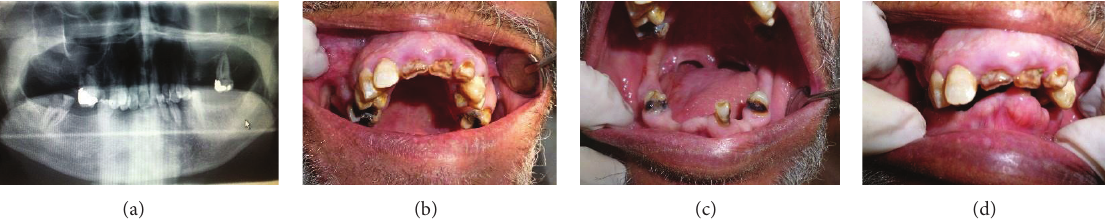
Figure 1: Preoperative status of patient: (a) panoramic view, (b) maxillary arch, (c) mandibular arch, and (d) both arches.